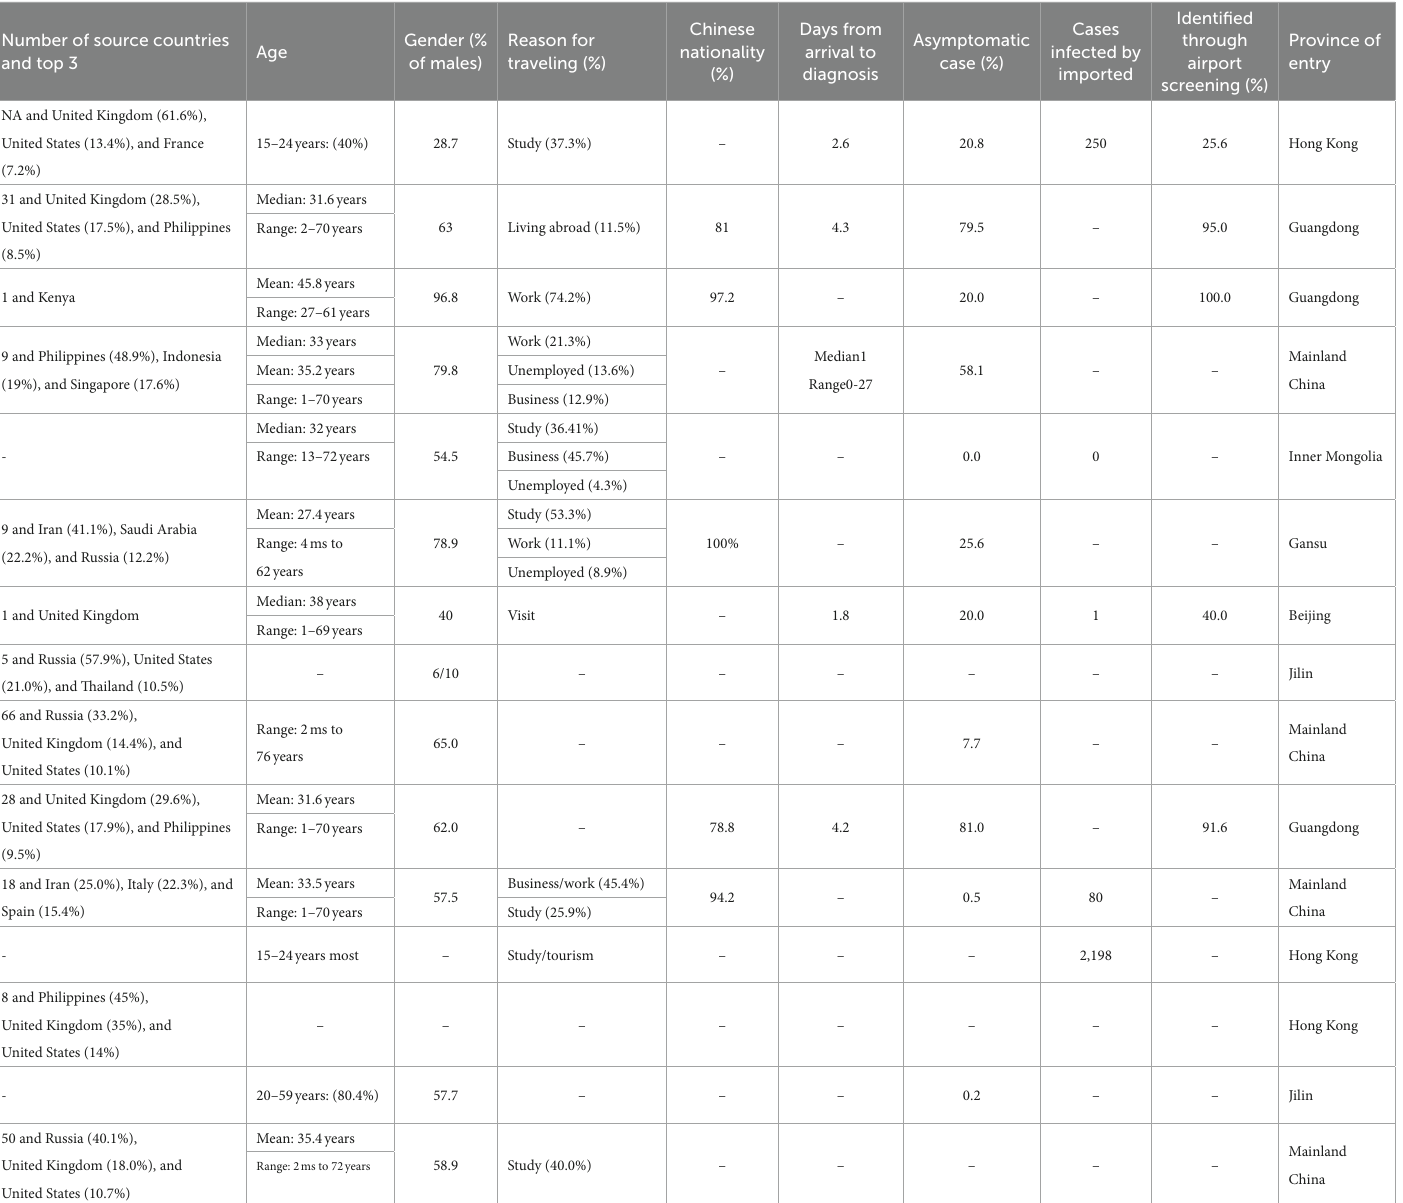
TABLE 2 Summary of 15 studies using data sourced from the websites of national/local health